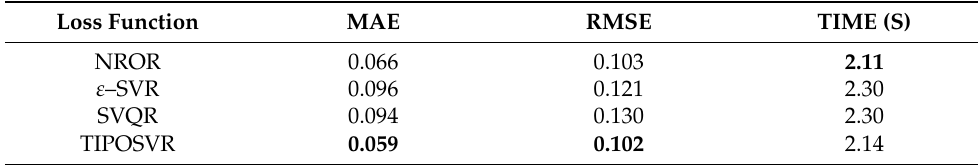
Table 9. Evaluation table based on real dataset experimental result. Loss